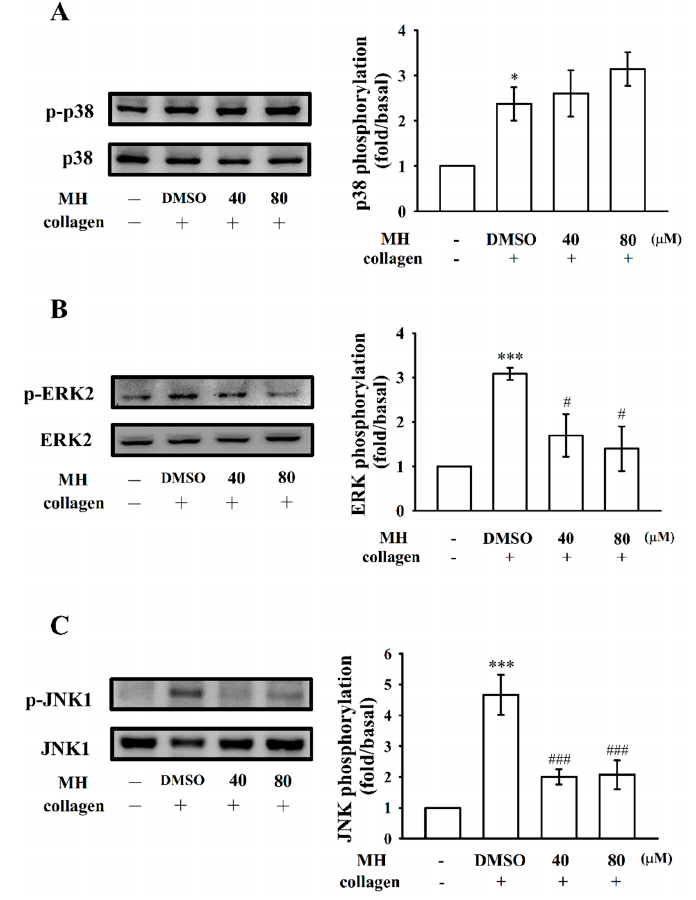
Figure 4. Morin hydrate inhibits p38 MAPK, ERK2, and JNK1 phosphorylation in collagen-activated platelets. Washed platelets were preincubated with the solvent control (0.1% DMSO) or morin hydrate (40 and 80 μ M) and subsequently treated with collagen (1 μ g/mL) to trigger ( A ) p38 MAPK, ( B ) ERK2, and ( C ) JNK1 activation. Data are presented as means ± standard errors of means ( n = 4). * p < 0.05 and *** p < 0.001 compared with the resting control; # p < 0.05 and ### p < 0.001 compared with the DMSO-treated group.